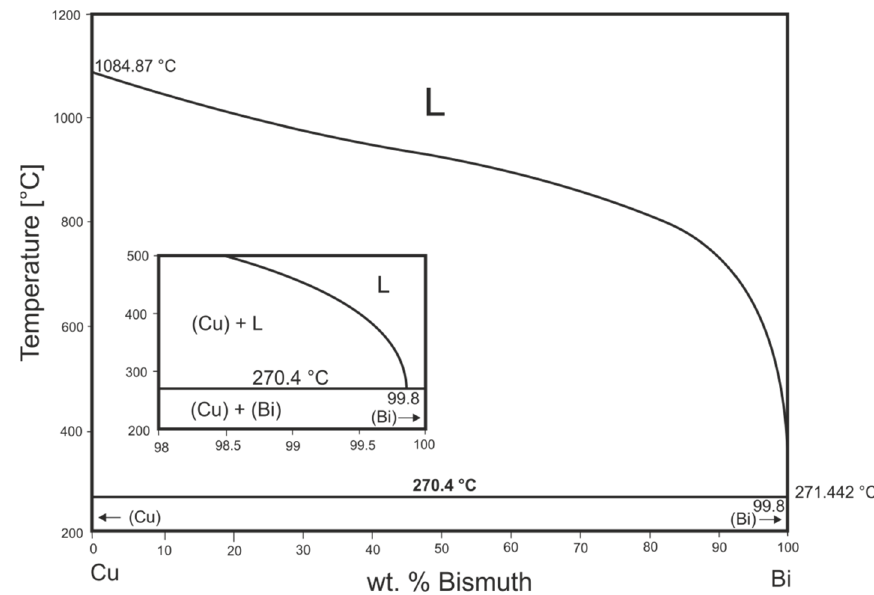
Figure 19. Equilibrium binary diagram of Cu-Bi [30].